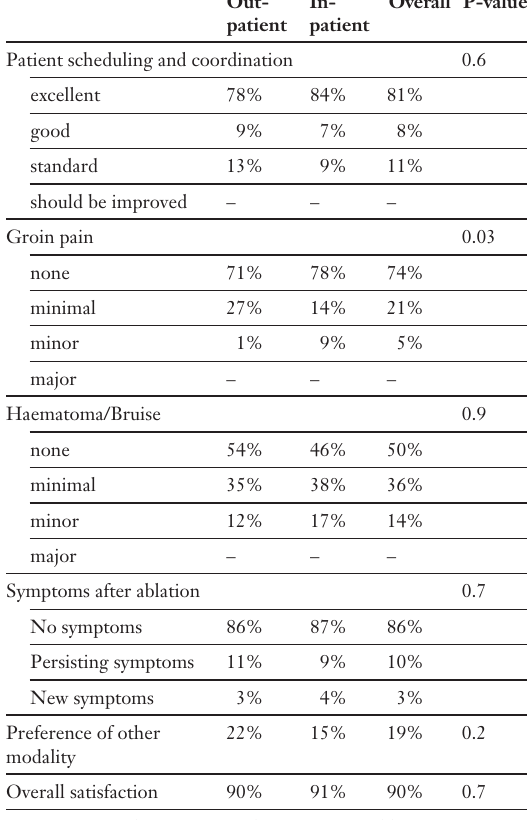
Out- In- Overall P-value patient patient